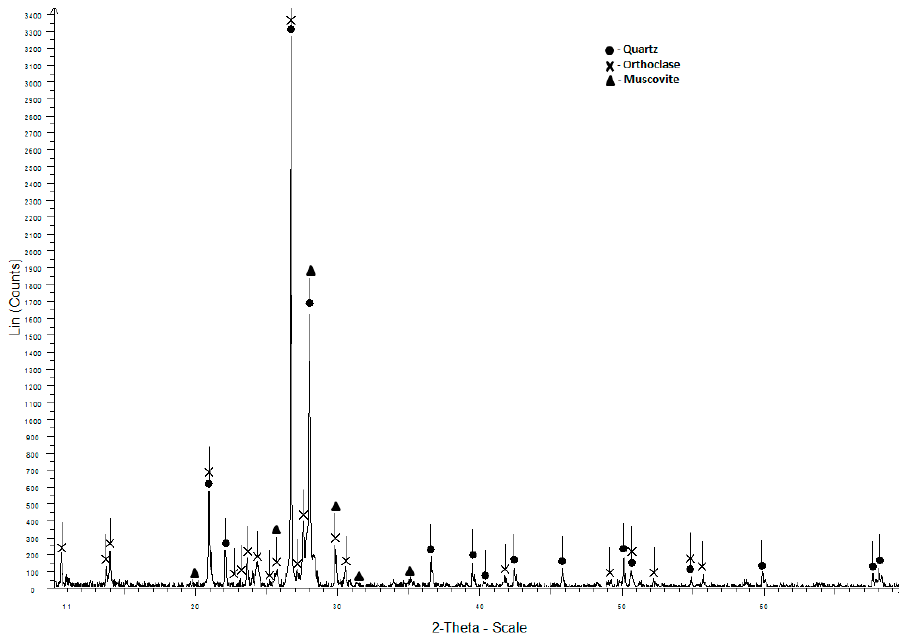
Figure 6. X-ray diagram of the quartz sand.